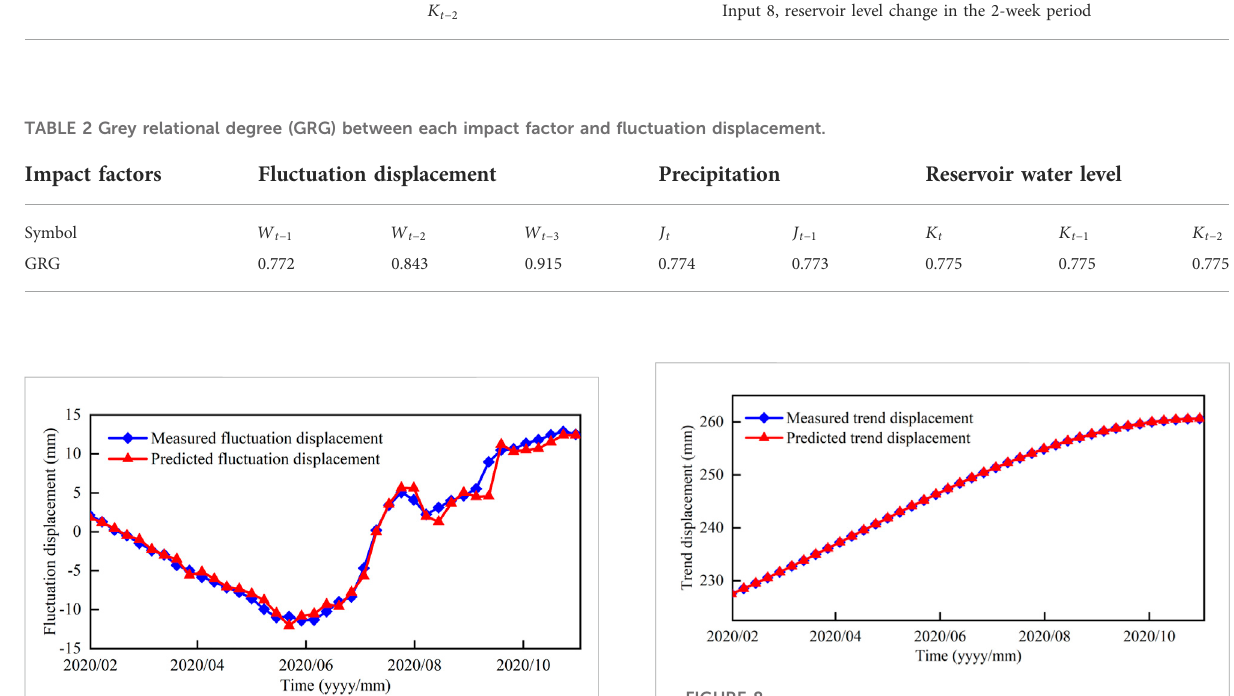
FIGURE 8 Prediction and comparison of the trend